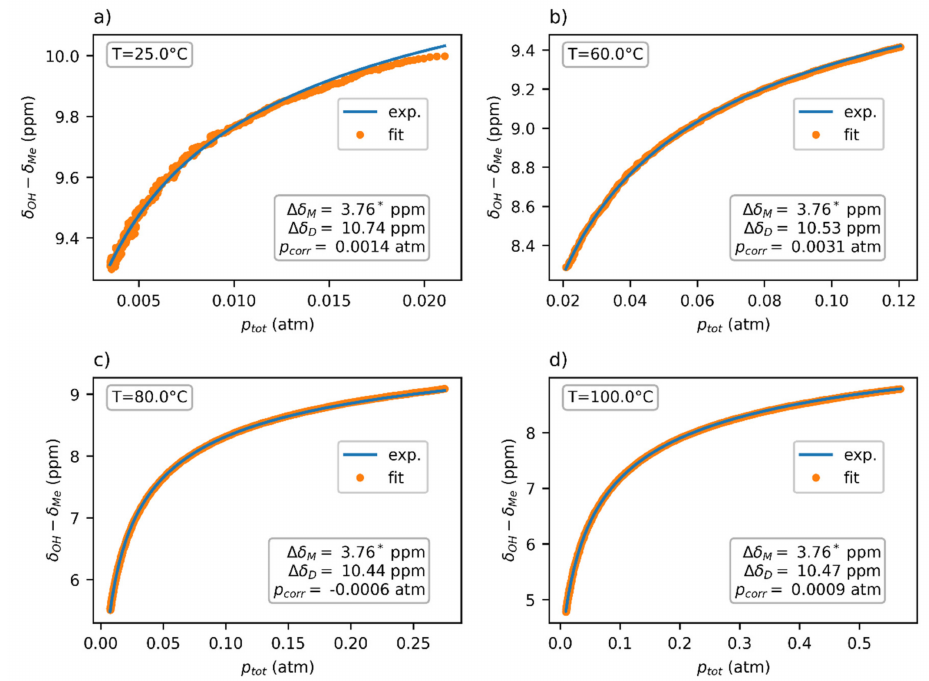
Figure 6. The pressure dependence of the chemical shift of acetic acid vapors in the FEP insert fitted using Expression (2). The chemical shift ∆ δ M was obtained independently through extrapolation from a 150 ◦ C dataset. Note that the p tot values used in the fit were based on the experimentally obtained concentration. The experimental temperatures were ( a ) 25 ◦ C, ( b ) 60 ◦ C, ( c ) 80 ◦ C and ( d ) 100 ◦